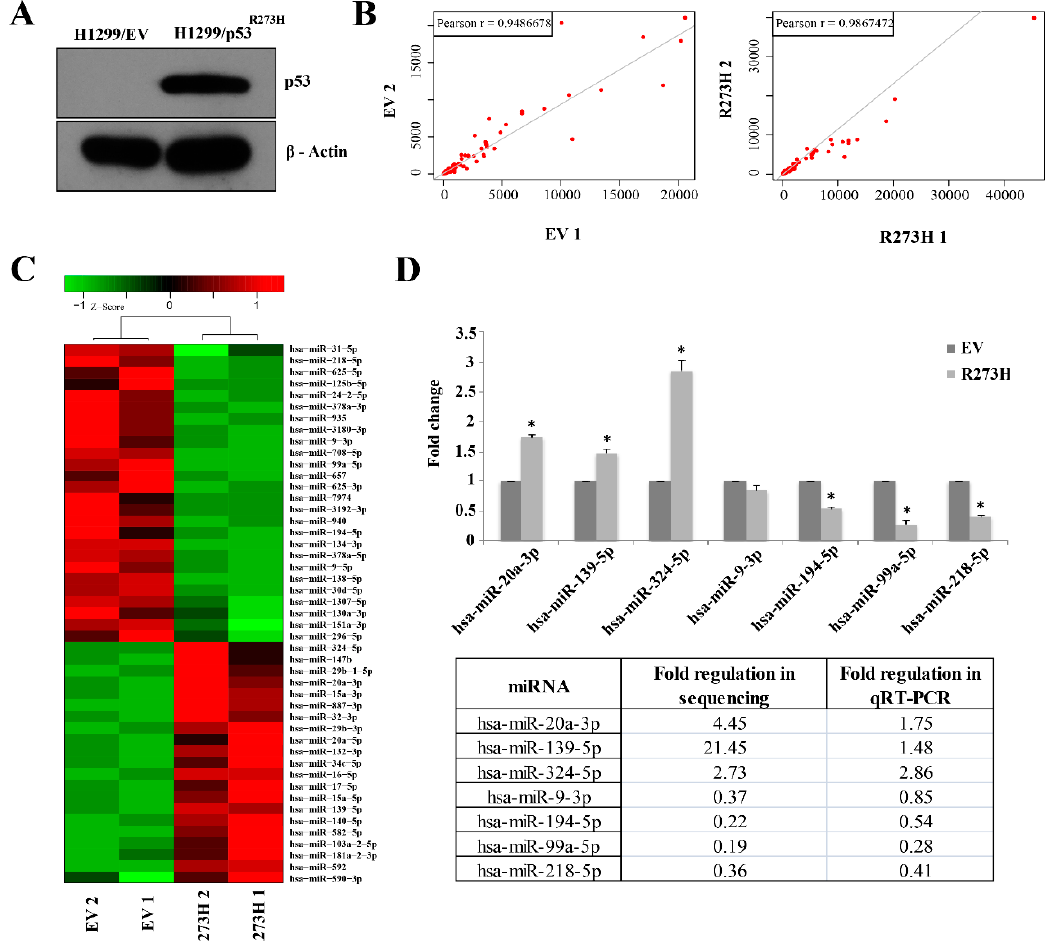
Figure 1. miRNA expression profiling in H1299 cells expressing mutant p53 R273H using small RNA sequencing. ( A ) Immunoblot showing mutant p53 R273H level in H1299 / mutant p53 R273H stable cells. ( B ) Scatter plots showing a correlation of normalized read counts between biological replicates of individual samples. ( C ) Heat map showing normalized read counts of miRNAs di ff erentially expressed ( p -value ≤ 0.05) between H1299 / mutant p53 R273H and H1299 / EV cells. Hierarchical clustering of samples is shown. Color bar indicates Z- scores of normalized read counts. Red color indicates high expression, green color indicates low expression. ( D ) Validation of the selected di ff erentially expressed miRNAs in H1299 / mutant p53 R273H cells using qRT-PCR. Bar graphs represent mean ± s.d.; n ≥ 2; two-tailed Student’s t -test: * p < 0.05. A relative comparison of qRT-PCR data with the deep sequencing results is shown.